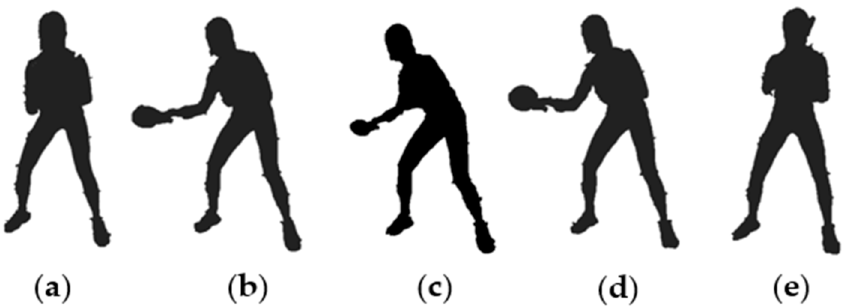
Figure 3. The stance interval of the chasse-step in this study, including ( a ) Ready Position, ( a – c ) Backward Swing Phase, ( c ) Backward Swing termination, ( c – e ) Forward Swing Phase, and ( e ) For- ward Swing